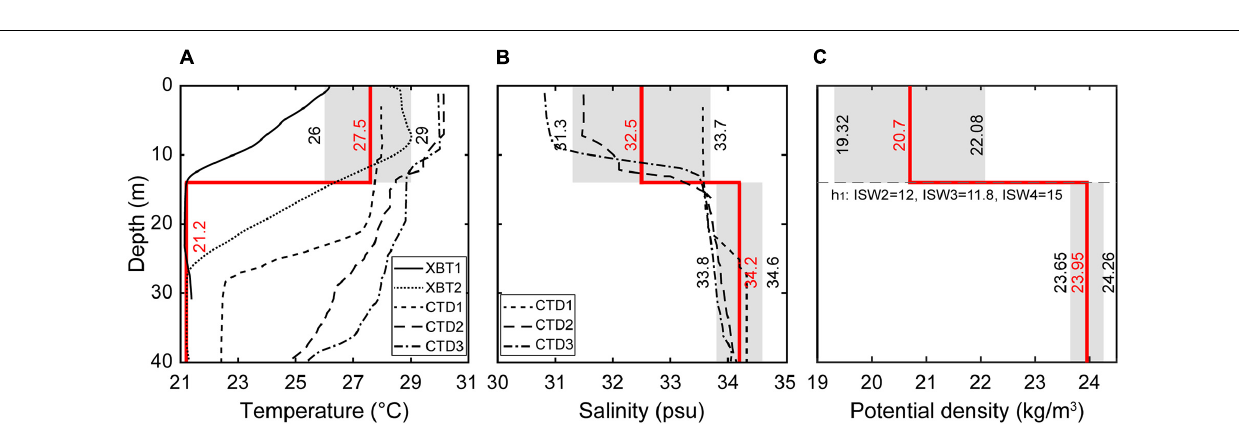
Frontiers in Marine Science |